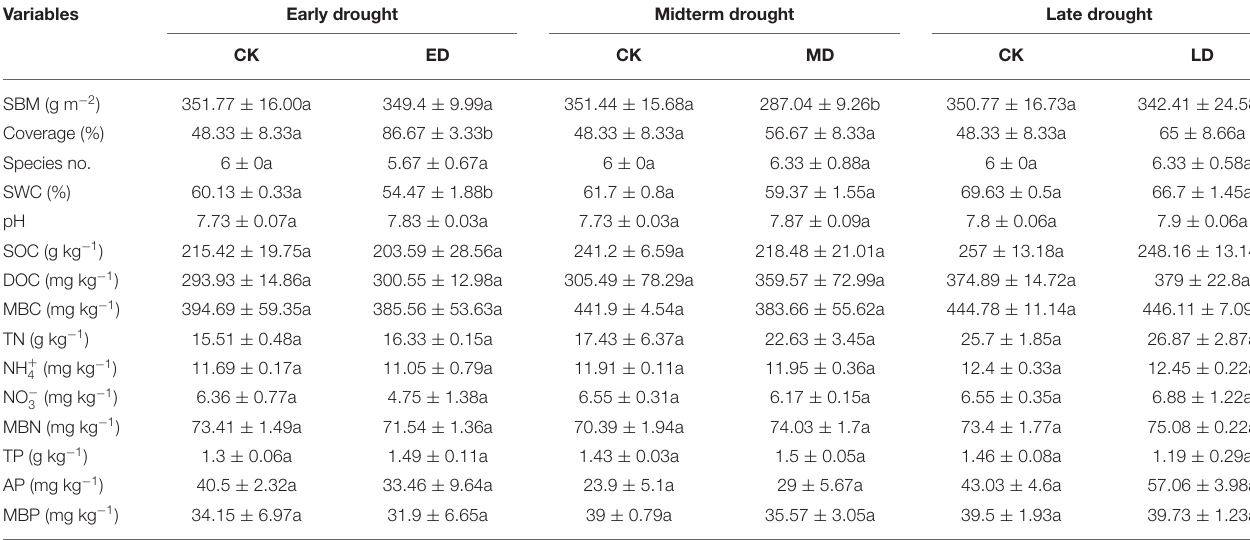
TABLE 2 | Plant and soil characteristics in the control period and different periods of extreme drought in 2019.